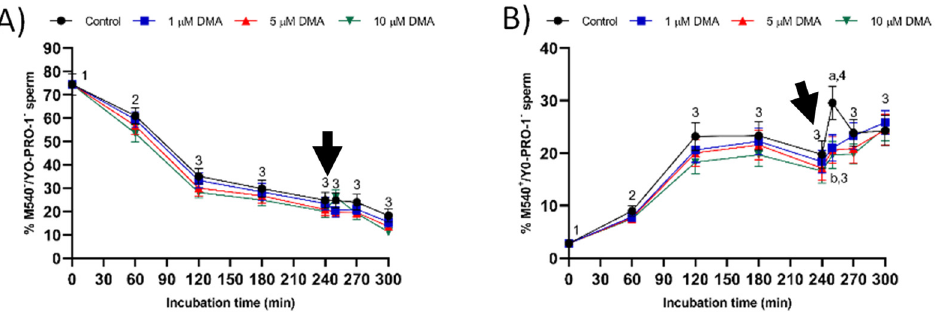
Figure 8. Percentages of viable sperm with low ( A ) and high membrane lipid disorder ( B ) during in vitro capacitation in the control and samples blocked with 1, 5, and 10 µM DMA. Different letter superscripts indicate significant differences between control and blocked samples within a single time point ( p < 0.05). Different numeral superscripts indicate significant differences between two consecutive time points within a treatment ( p < 0.05); since the pattern of variation of the percentage of viable sperm with low membrane permeability was similar between control and blocked samples throughout the incubation time, all treatments have the same numeral superscript assigned to each time point. The arrow indicates the addition of 10 µg/mL of progesterone at 240 min of incubation. Results are expressed as the mean ± SEM ( n = 9).